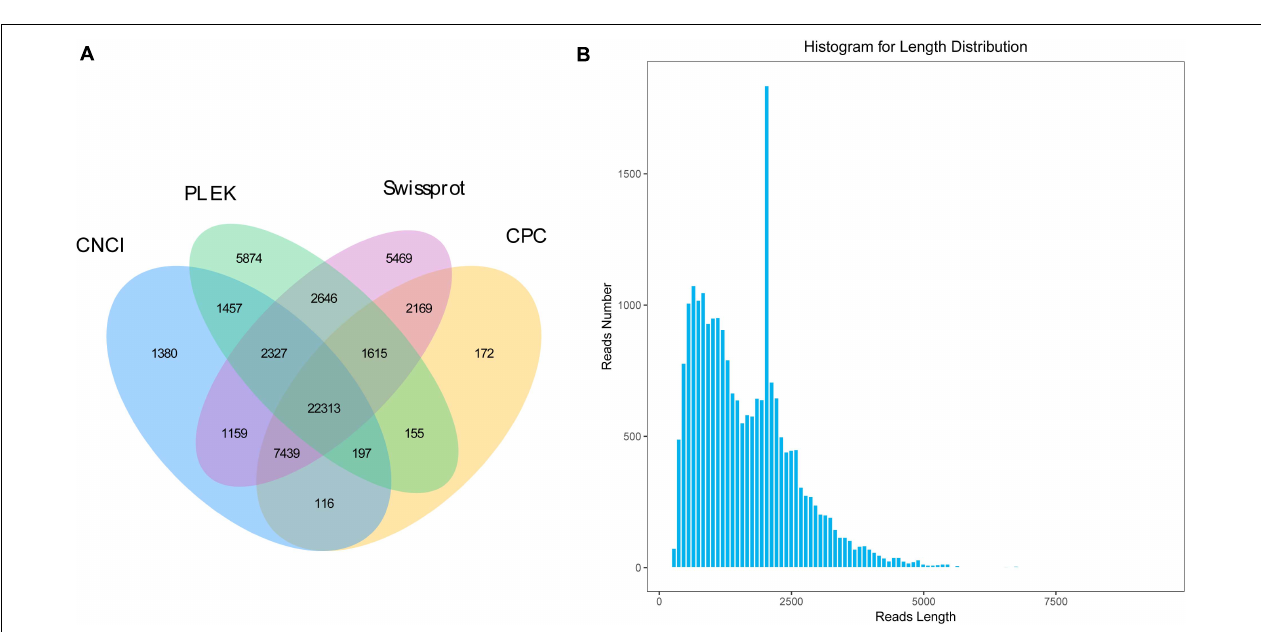
FIGURE 3 | The identification and length distribution of long non-coding RNA (LncRNA). (A) Overlapping results of LncRNA from the different method, (B) Length distribution of LncRNA.